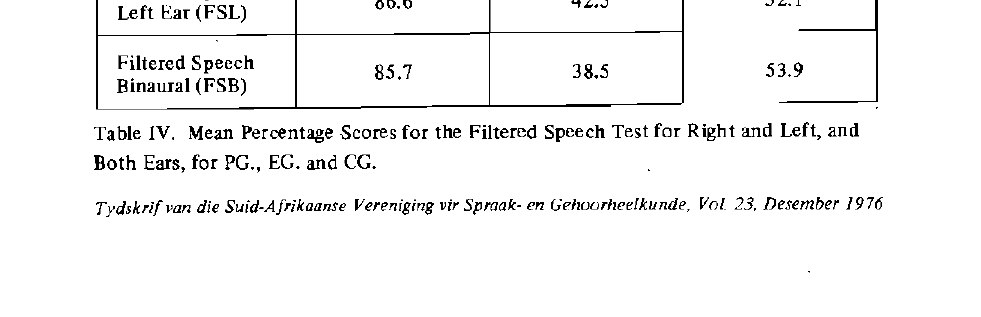
Table IV. Mean Percentage Scores for the Filtered Speech Test for Right and Left, and Both Ears, for PG., EG. and